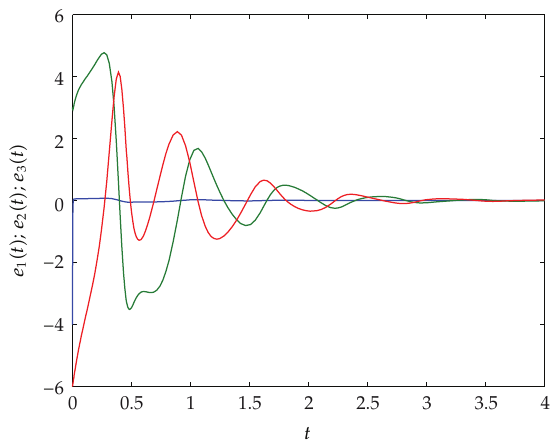
Figure 4: Synchronization errors of systems (cid:3) 2.1a (cid:4) – (cid:3) 2.1d (cid:4) and (cid:3) 2.2a (cid:4) – (cid:3) 2.2d (cid:4) , with a (cid:8) 0 . 4 and Δ φ i (cid:3) u i (cid:4) (cid:8) u i , ∀ i ∈ { 1 , 2 , 3 } , under the control proposed in (cid:6) 8 (cid:7) .